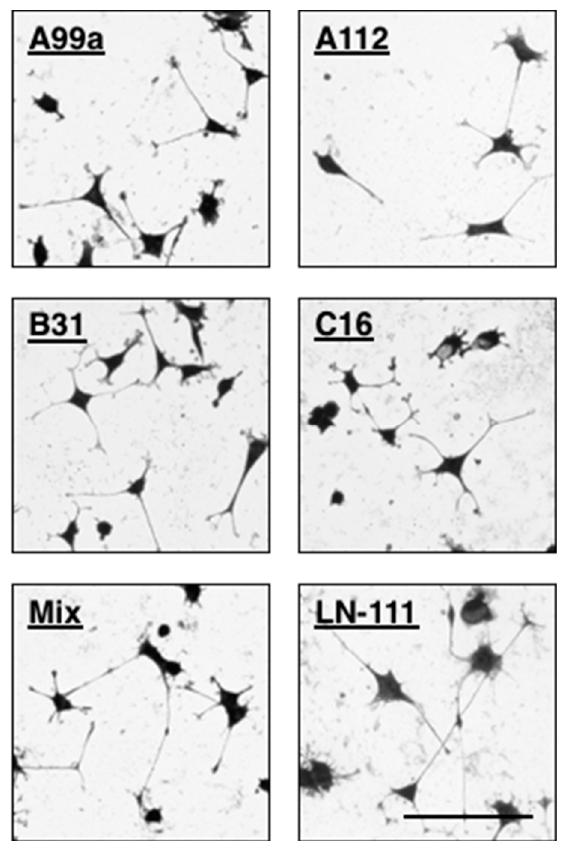
Figure 6. Neurite outgrowth activity of multipeptide–chitosan matrices mimicking LM-111. CGG-A99a, CGG-A112, CGG-C16, and CGG-B31 (10 nmol/well), and four peptides mixture (each peptide 2.5 nmol/well; total peptide 10 nmol/well) were coupled to the MB–chitosan matrices in 96-well plates. The PC12 cells were allowed to incubate on the peptide–chitosan matrices for 24 h and then stained with crystal violet. Scale Bar is indicated 100 μ m. (Adapted with permission from [65], copyright 2012 Elsevier).